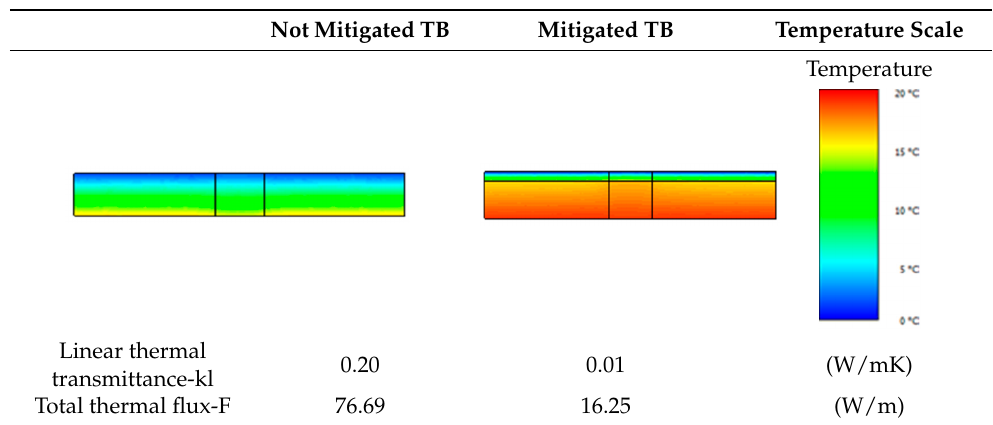
Table 14. P Thermal bridges.